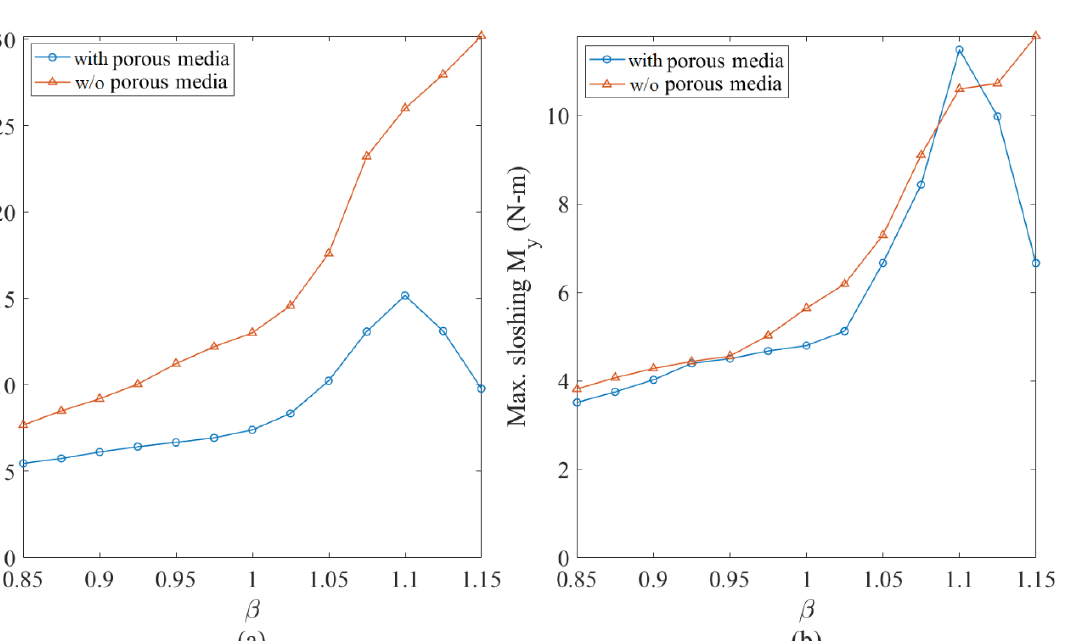
Figure 36. The frequency responses of the local sloshing behavior in the water tank on a floating body for the small-wave case: ( a ) maximum dynamic pressure on the wetted wall; ( b ) normalized height of pressure concentration. 5. Conclusions From this study, some conclusions can be drawn: 1.